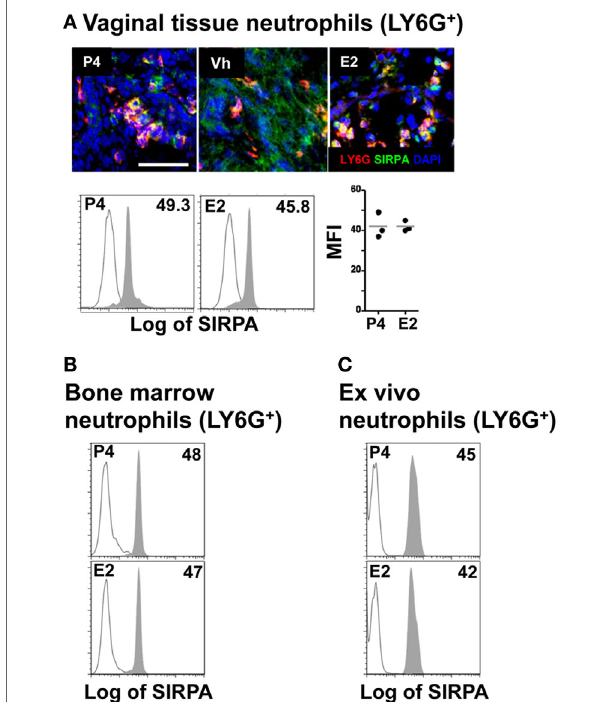
FigUre 4 | Hormone-treated ovariectomized mice were mock or Candida albicans inoculated in the vagina. (a) Representative pictures of sections assayed for SIRPA (green) and LY6G + (red). Representative flow cytometry plots and quantification of the SIRPA expression in LY6G + neutrophils from the lower female reproductive tract of hormone-treated mice. SIRPA expression in LY6G + neutrophils from in vivo hormone-treated mice, (B) bone marrow, and (c) ex vivo treated neutrophils. Scale bar, 50 µm. Isotype control mAb (line) and indicated mAb (gray filled lines). Each circle represents a mouse (a) , n = 4 in (B) , and n = 5 in (c) . Abbreviations: E2, estradiol; Vh, vehicle; P4,